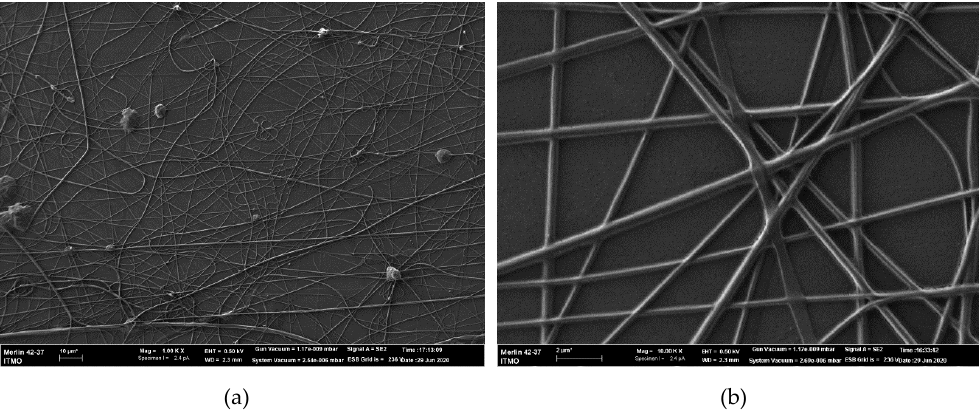
Figure 6. SEM images of curcumin/usnic acid-loaded hyaluronic acid fibers electrospun from the polymer solutions under 28 kV: ( a ) magnification 1000×; ( b ) magnification 10,000×.